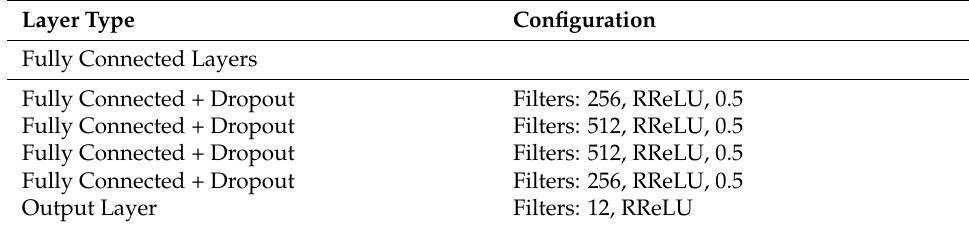
Table 5. The architecture of